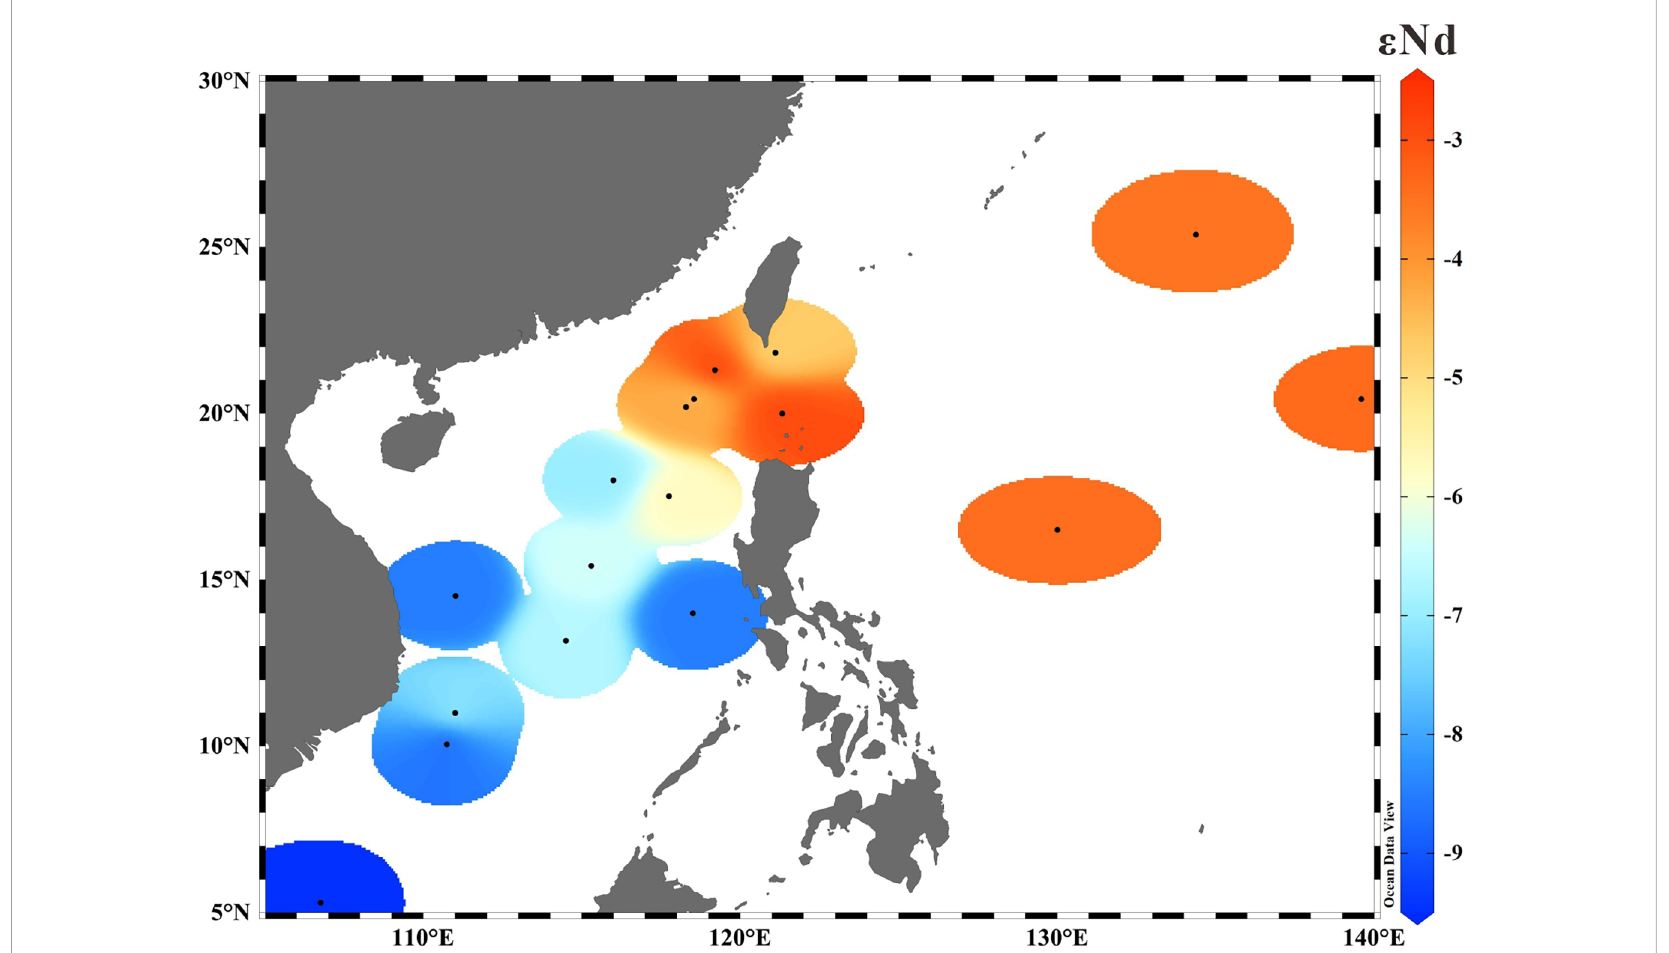
FIGURE 7 Distribution of surface water ϵ Nd in the SCS and West Paci fi c. Data sources: this study, Amakawa et al. (2000); Wu et al. (2015), and Behrens et al. (2018b). The fi gure was created using Ocean Data View (Schlitzer,